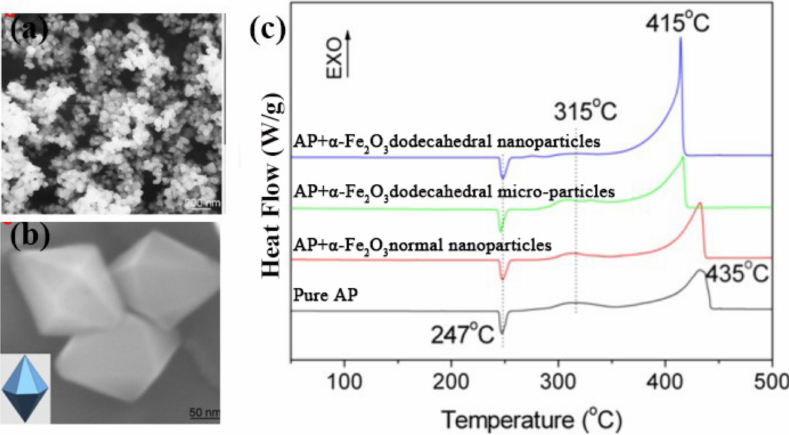
Figure 1. SEM images of ( a ) synthesized product; The inset of ( b ) is a geometrical model of the dodecahedral particle; ( c ) DSC curves for pure AP, AP+ α -Fe 2 O 3 dodecahedral nanoparticles, AP+ α - Fe 2 O 3 normal nanoparticles, AP+ α -Fe 2 O 3 dodecahedral micro-particles. ( a – c ) Reproduced with the permission of ref. [35]. Copyright 2014, Journal of Nanoparticle